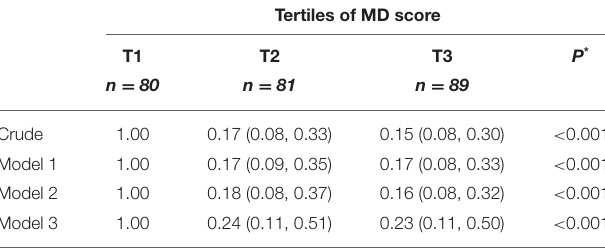
TABLE 4 | Odds ratio (95% CI) of severe disease according to tertiles of Mediterranean diet. Tertiles of MD score